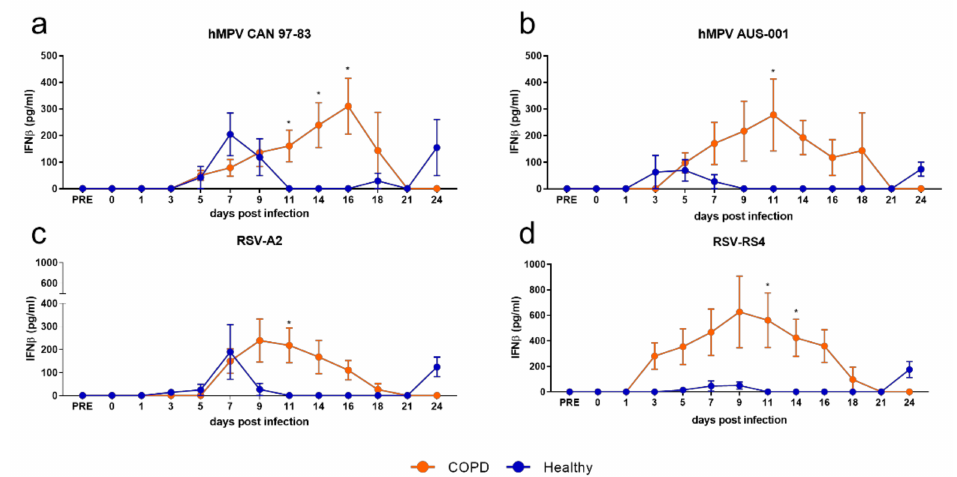
Figure 6. IFN- β production by well-differentiated BEC cultures infected with ( a ) CAN 97-83 ( b ) AUS- 001 ( c ) A2 or ( d ) RS4, MOI 3. Basal medium was sampled 3 times per week and secreted IFN- β quantified by AlphaLISA. The symbols represent the mean ± SEM. n = 5 for both COPD and healthy groups. Unpaired t -tests show statistical significance, * denotes p <